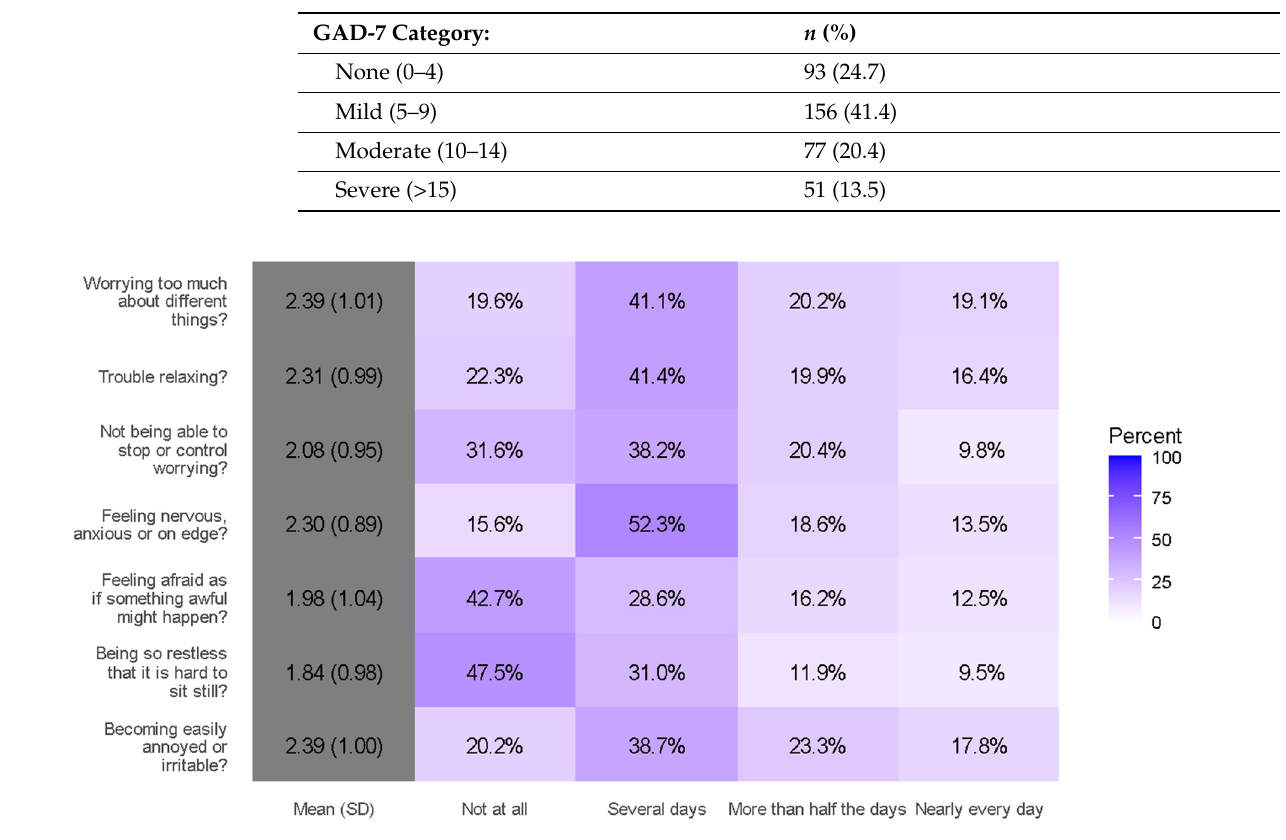
Figure 1. Responses to individual GAD-7 items.